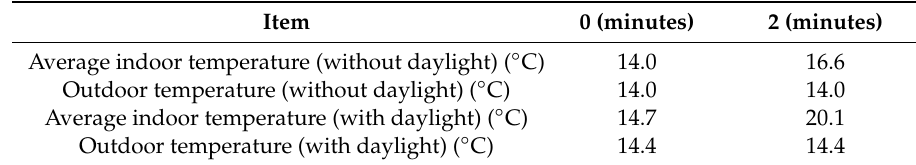
Table 6. Sensor measurement results in winter.